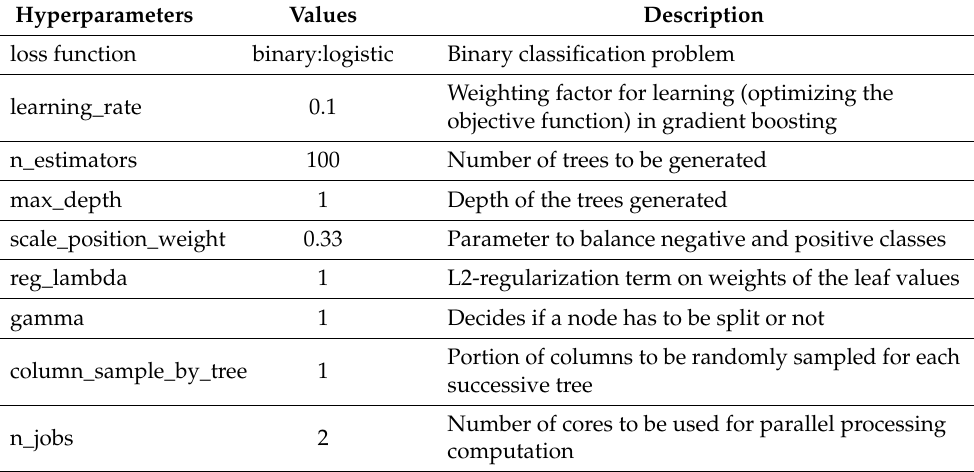
Table 1. Hyperparameter values of extreme gradient boosting (XGBoost) used in the dynamic electricity theft detector